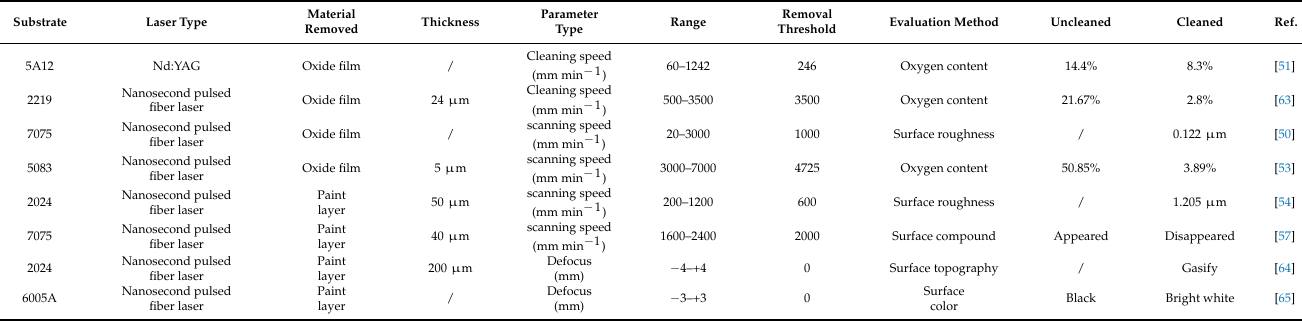
Table 2. Optimization of laser space